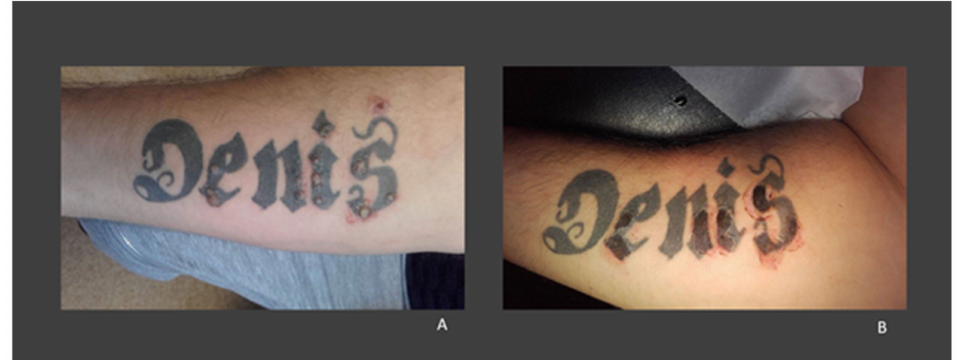
Figure 2. ( A ) A 30-year-old man with warts on a tattoo with black pigment on his left forearm. ( B ) The aspect of the tattoo after curettage and electrosurgery of the lesions (images from our clinic, previously published in Georgescu et al., 2017